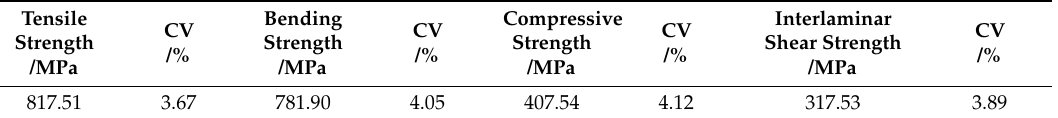
Table 6. Mechanical properties of composite samples prepared by compression resin transfer molding (CRTM).